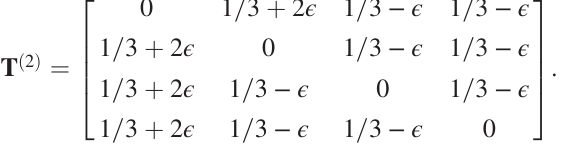
FIG. 9. Scenario 3. Normalized Kullback-Leibler divergence D ð m Þ between X ð t Þ and its Markovianized surrogate Y ð t Þ in the case where the second layer has a shortcut, which is traversed with probability ϵ (scenario 3) and the switching rate is r ¼ 0 . 1 . For ϵ ¼ 0 , both layers are identical, and the walker is essentially navigating over a monoplex; therefore, X ð t Þ is Markovian, and D ð m Þ ¼ 0 ∀ m . For ϵ > 0 , the graph is multiplex; therefore, D ð m > 2 Þ > 0 , and such a feature is detected with quantitatively larger fingerprints as ϵ increases.